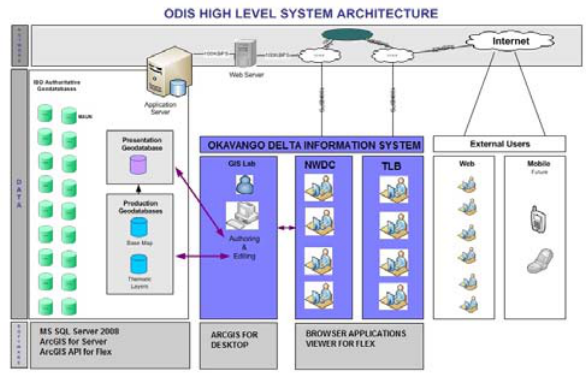
Figure 2. Proposed ODIS Architecture providing access to multiple external users via Internet browser web mapping